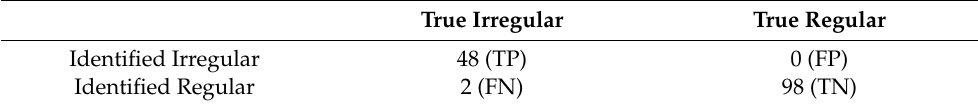
Table 8. Identification results using